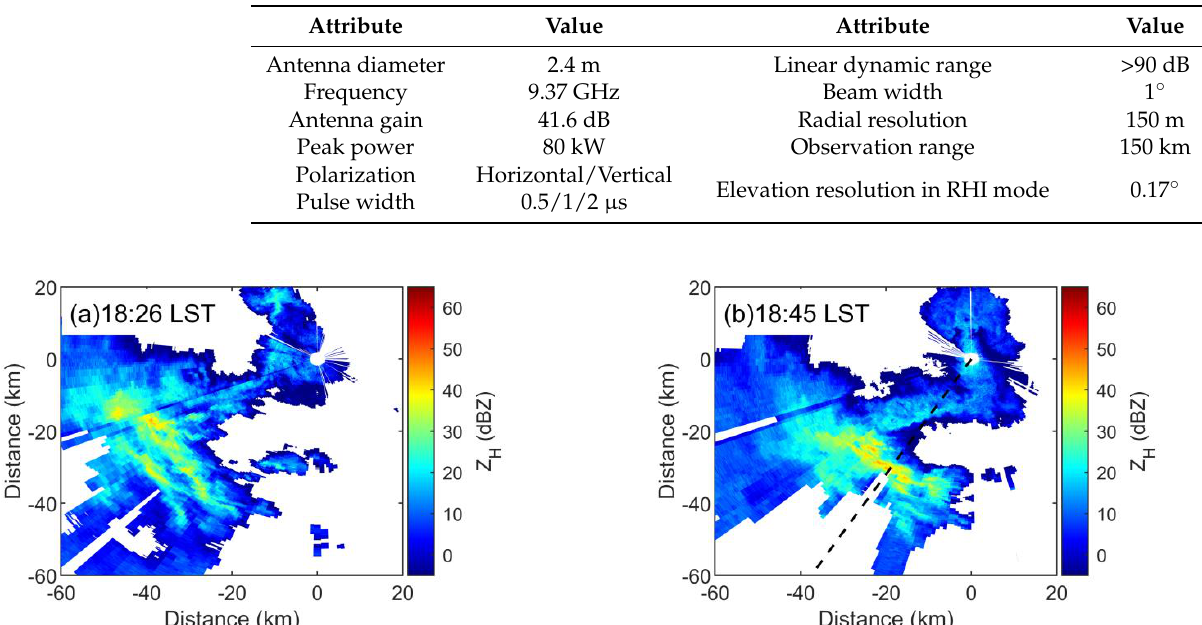
Table 1. Characteristics of the X-band dual polarization radar used in this paper.